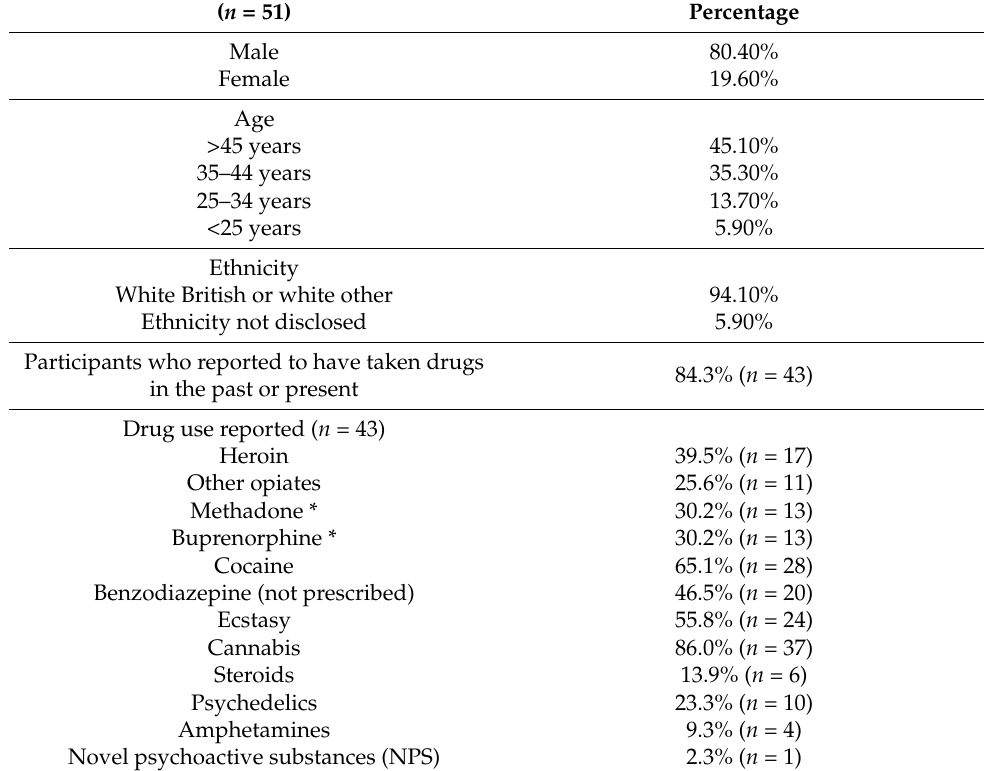
Table 1. Participant